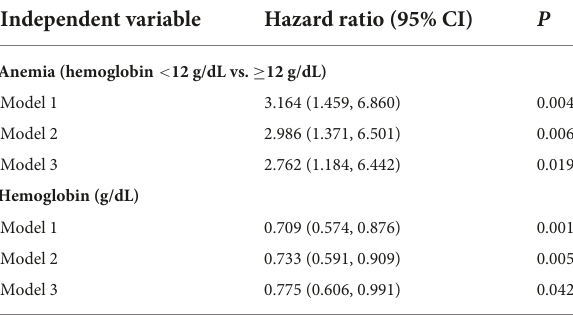
TABLE 2 Associations of pre-operative anemia and hemoglobin with all-cause